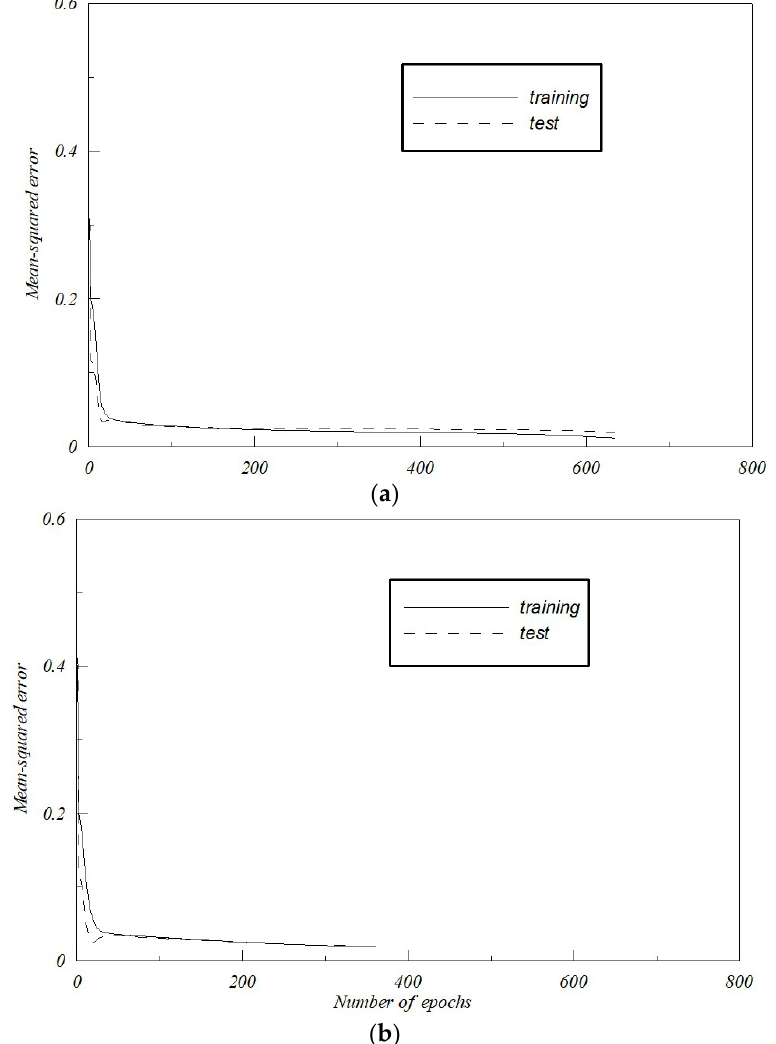
Figure 6. ( a ) The performance of the model using the training/test dataset for SVM; ( b ) the perfor- mance of the model using the training/test dataset for MLP.